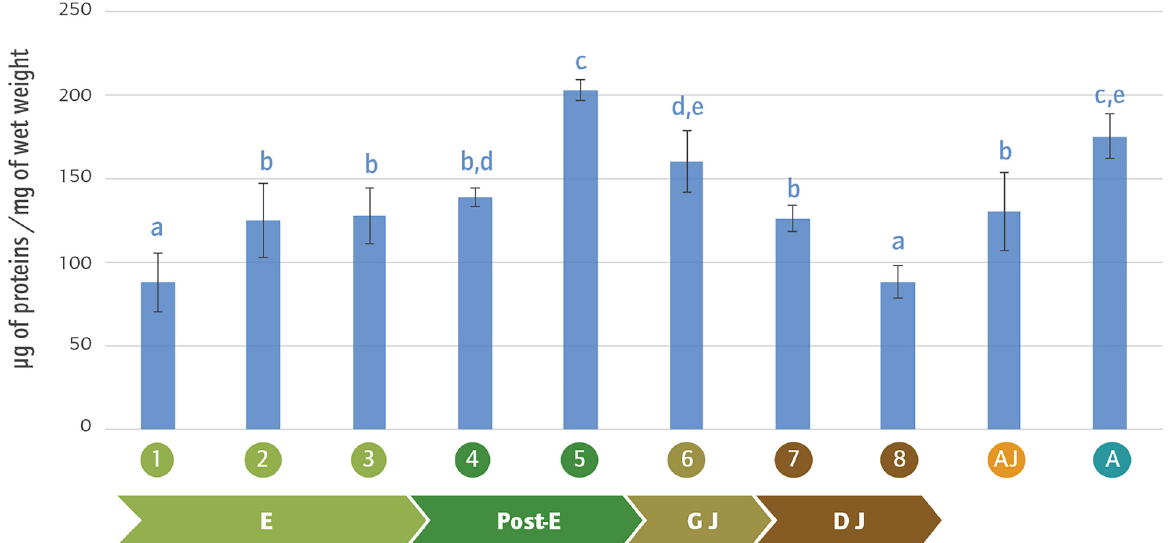
Figure 2. Analysis of protein concentration during P. pythagoricus development until adult’s stage. Values are the means ± SDs. Different letters above the bars indicate significant differences among the different stages at p < 0.05, as determined by Tukey’s post hoc test. 1 to 8: stages of P. pythagoricus development; AJ: advanced juvenile stage; A: adult stage; E: embryonic period; Post-E: post-embryonic period; GJ: juveniles in gregarious stage; DJ: juveniles in dispersal